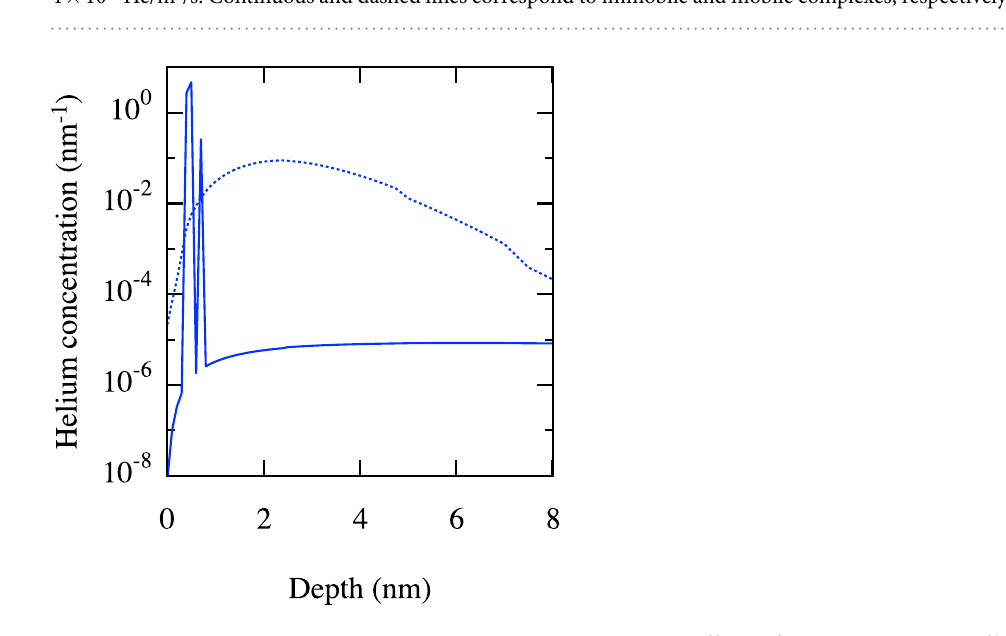
Figure 7. Helium concentration as a function of depth for a flux of 4 × 10 22 He/m 2 /s at a fluence of 4 × 10 20 He/ m 2 . Continuous and dashed lines correspond to immobile and mobile complexes,